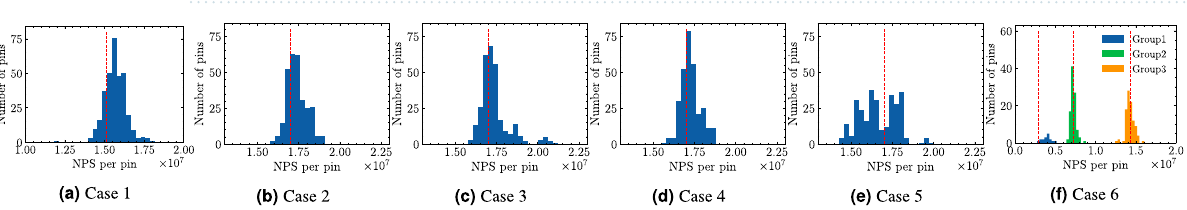
Figure 6. Pin identifications based on the inverse approach. Identified pins are shown as red circles. For Cases 1 to 5, we achieved 100% classification accuracy; for Case 6, we achieved 100% classification accuracy for the pins of medium and high activity level.